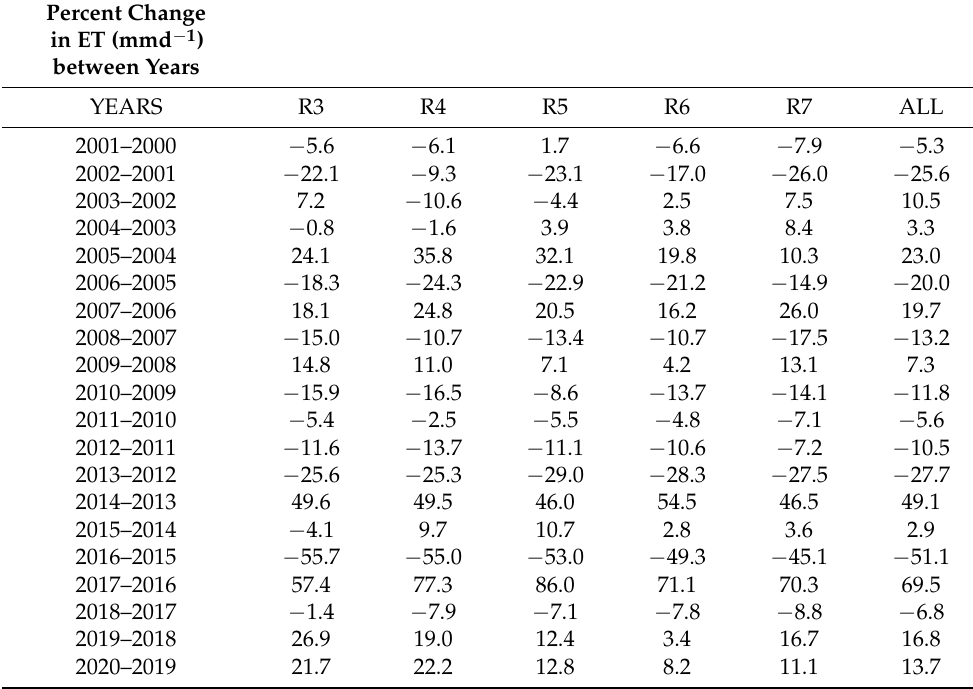
Table A7. Percent change between years for the average daily water use using dates for the peak growing season (1 May to October 30) for each of the 21 years in the study. ET (mmd − 1 ) change is either positive or negative ( − ) and the data is shown for each reach and the weighted average in All reaches.